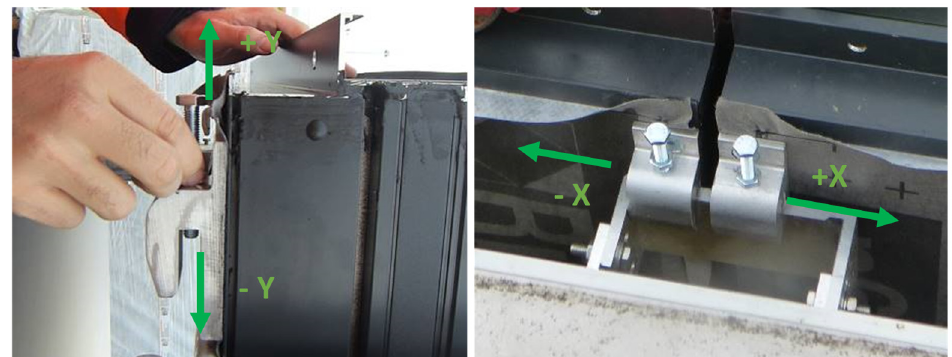
Figure 6. System’s fixing design, with possibility of adjustment in the “y” axis and in the “x” axis.